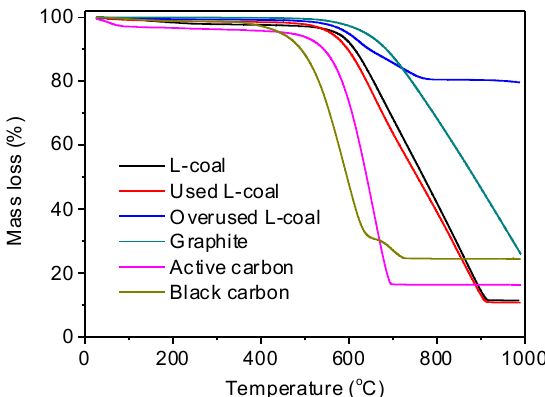
Figure 4. TG data of coal and various carbon materials in air (20 mL/min). L-coal powder after reaction under 30 kPa P O 2 was named as overused L-coal powder. The used L-coal is the raw L-coal after reaction under 7.5 kPa O 2 at below 500 °C.